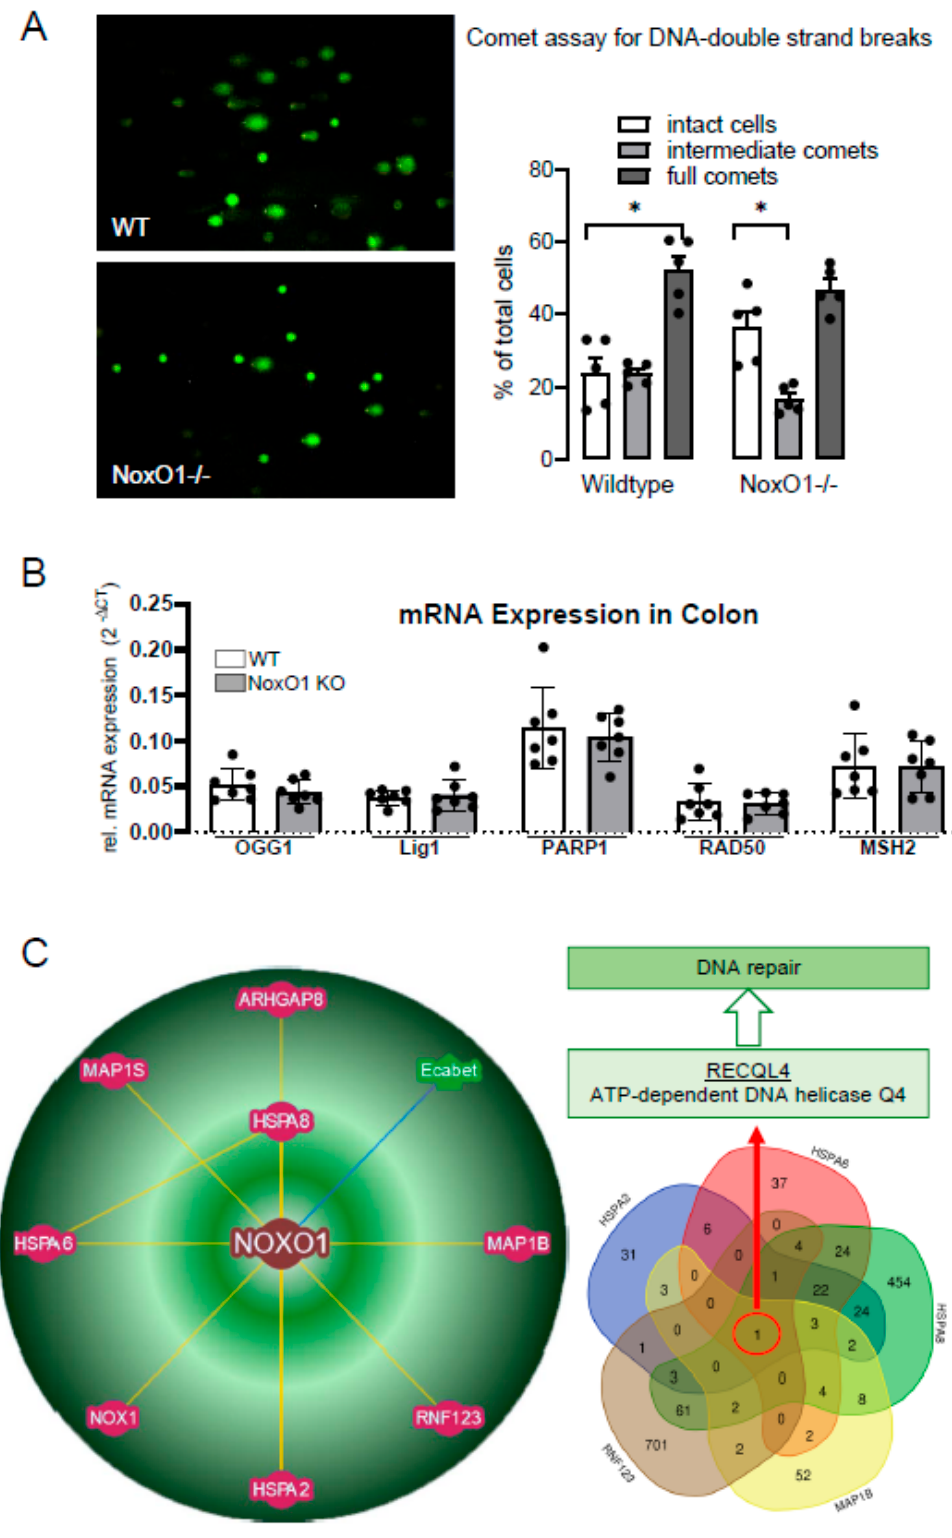
Figure 4. ( A ) Comet assay of isolated enterocytes of male mice at the age of 12 weeks with representative pictures and statistics. n = 5 (5 mice with 5 pictures for individual means); ( B ) QPCR for the genes indicated in colon tissue of 7 mice; * p < 0.05. ( C ) BioGRID 3.5 based network of potential binding partners of NoxO1 and Venn diagram of secondary interaction partners (VIB / UGent; Bioinformatics and Systems Biology; Gent; BELGIUM).